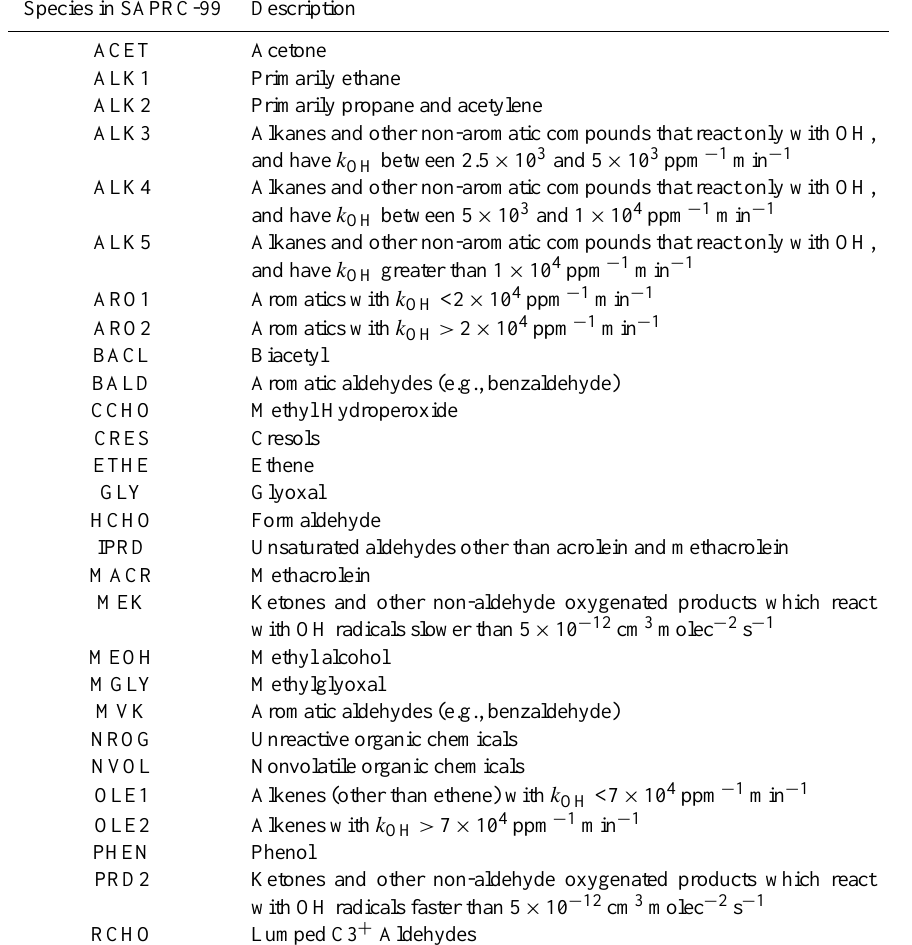
Table A1. Description of SAPRC-99 NMVOC emitting species from anthropogenic sources ∗ . Species in